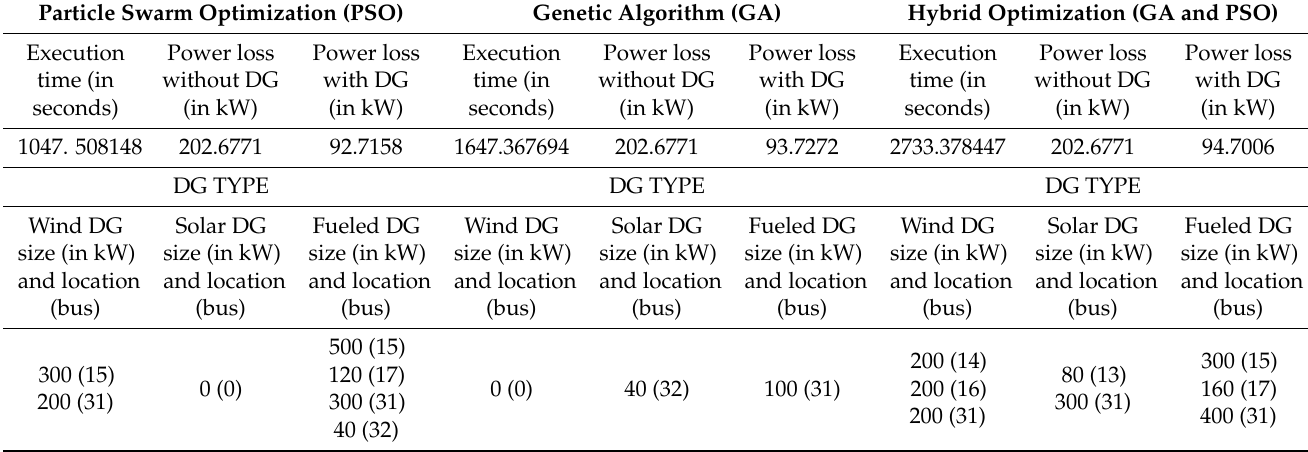
Table 10. Results for optimal DGs size and their corresponding optimum location using by MCS for scenario-2 using different metaheuristic optimization